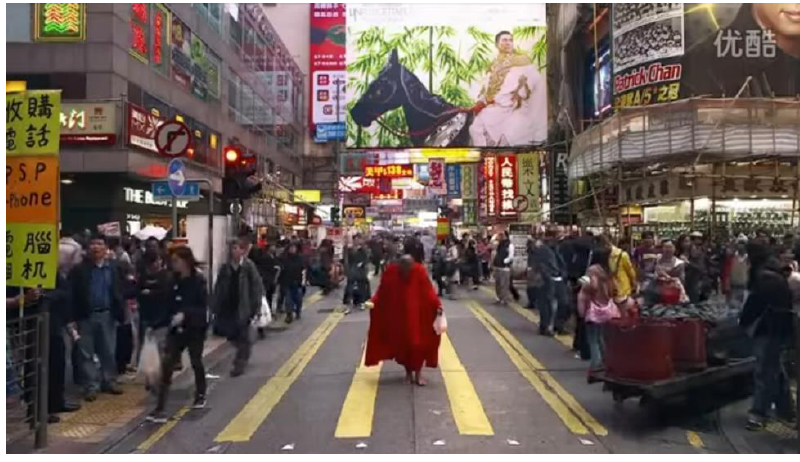
Figure 2. Self-reflexive performativity on a pedestrian crosswalk.